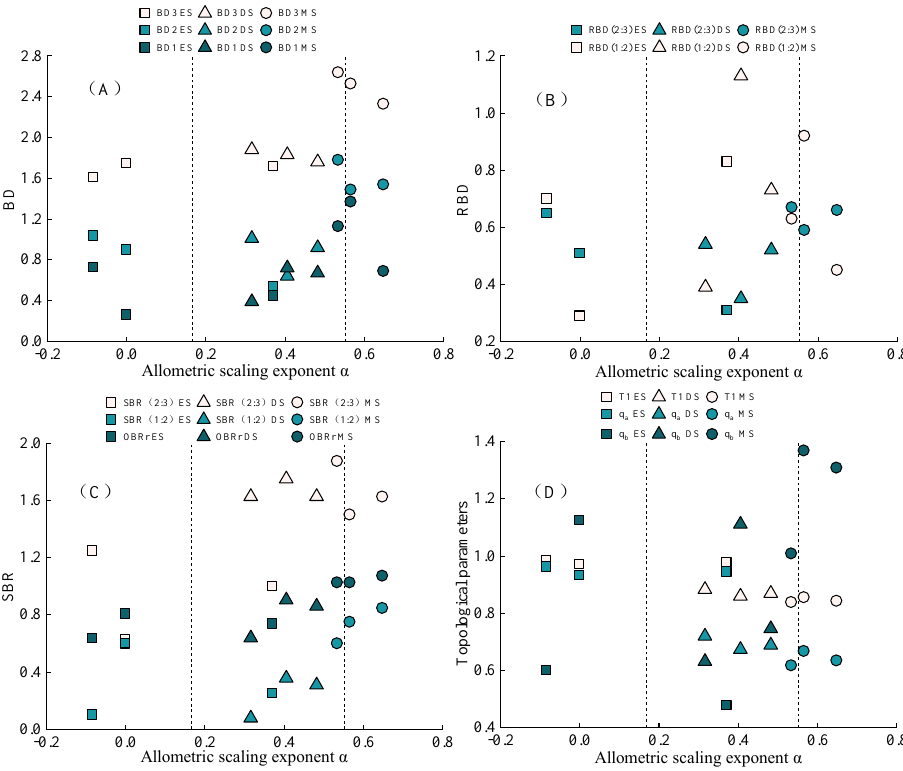
Figure 2. Scatter plots were created using allometric scaling exponent α as the X-axis and adventitious root architecture parameters as the Y-axis. The two reference lines indicate the growth in shrub and nabkha at the same rate. The left side of the reference line indicates that the nabkha grows faster than the shrub. The right side of the reference line indicates that the nabkha grows slower than the shrub. RS: rudimental stage; DS: developing stage; SS: stabilizing stage. ( A ) BD; ( B ) RBD; ( C ) SBR; ( D ) topological index.